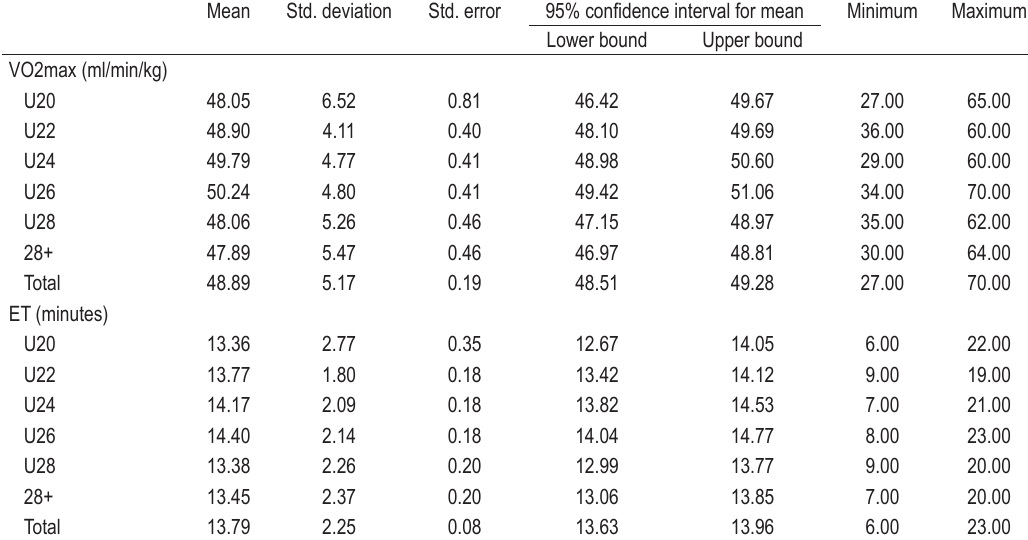
TABLE 3. Descriptive statistics of maximal oxygen consumption (VO2max) and exercise time (ET) for age different groups Mean Std. deviation Std. error